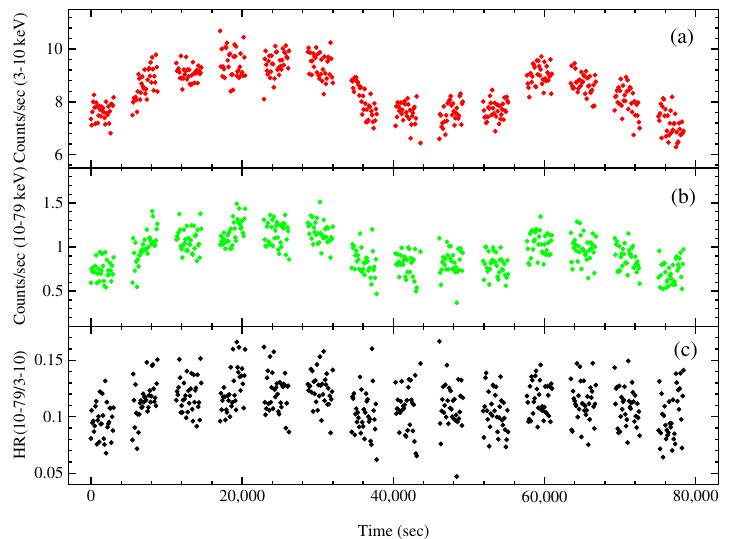
Figure 2. The variation of ( a ) 3–10 keV count rate, ( b ) 10–79 keV count rate, and ( c ) hardness ratio (HR) with time (in sec). The light curves are binned with a time resolution of 100